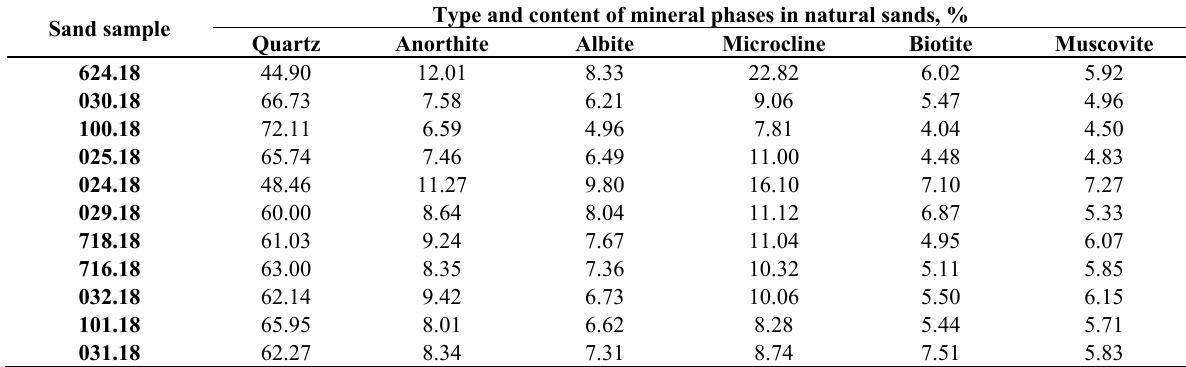
Table 3. Semiquantitative proportions of mineralogical phases, by FEG-SEM/EBSD, in natural sands. Sand